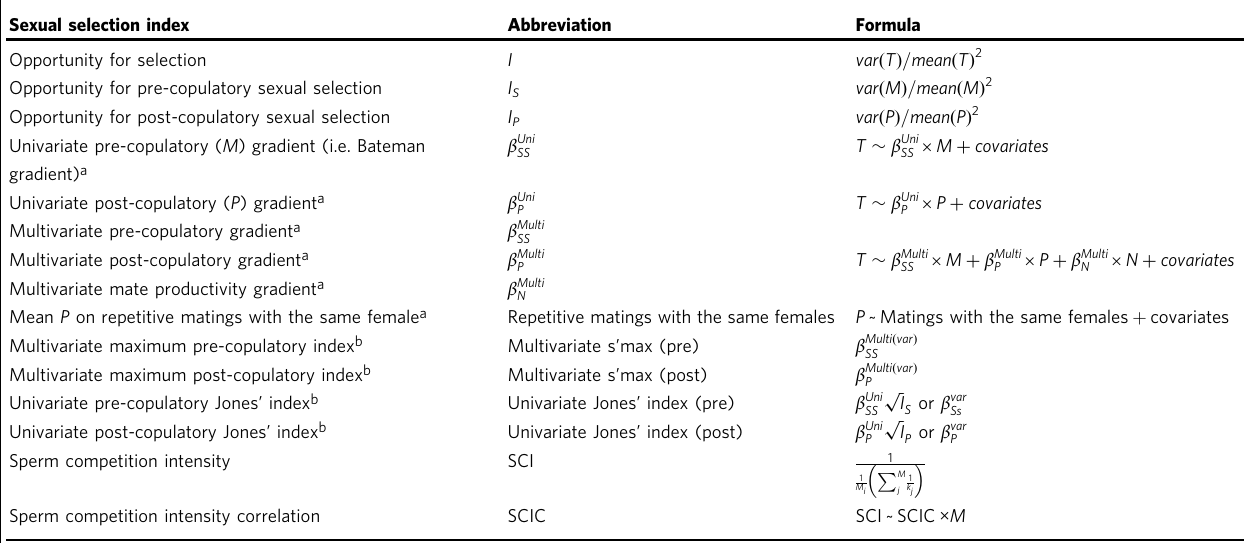
Table 1 Sexual selection indexes and formulas used for their calculations